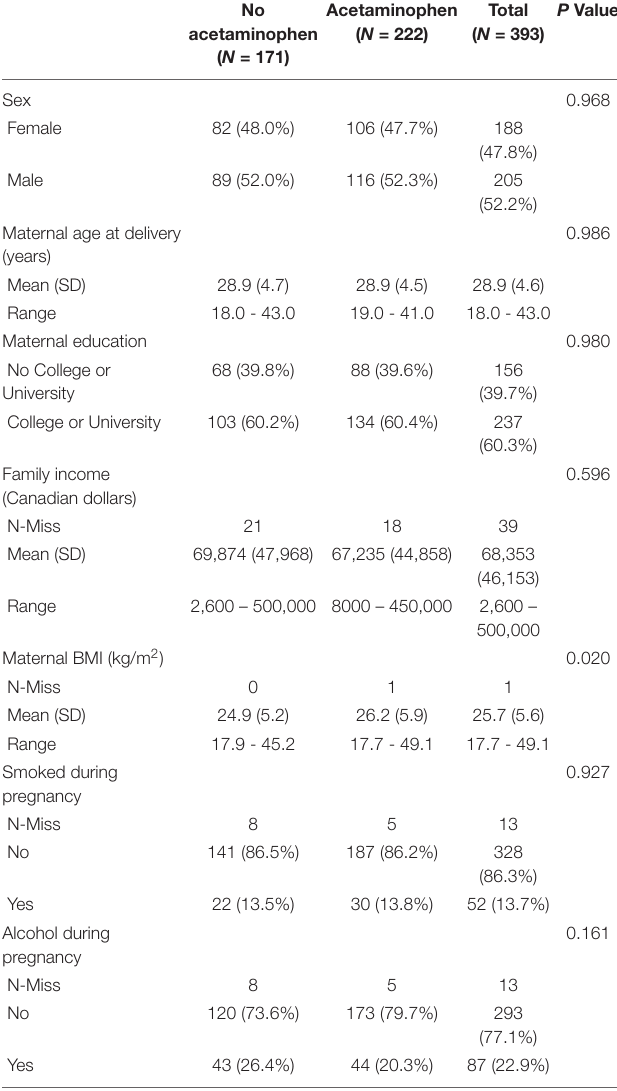
TABLE 1 | Characteristics of study sample stratified by detection of acetaminophen in meconium in the Gestation and the environment (GESTE) cohort ( n = 393).